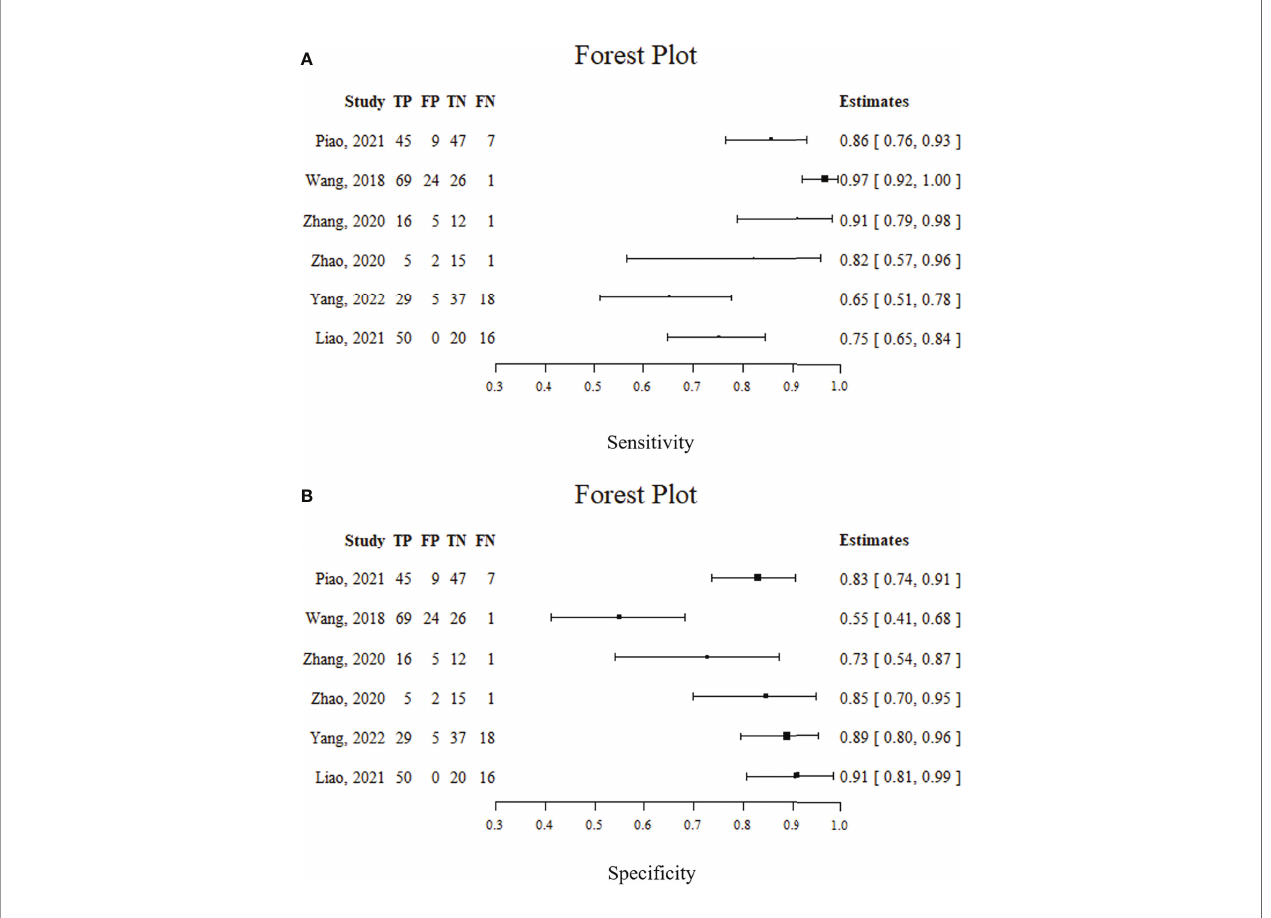
FIGURE 3 | Forest plots. (A) sensitivity; (B) speci fi city.